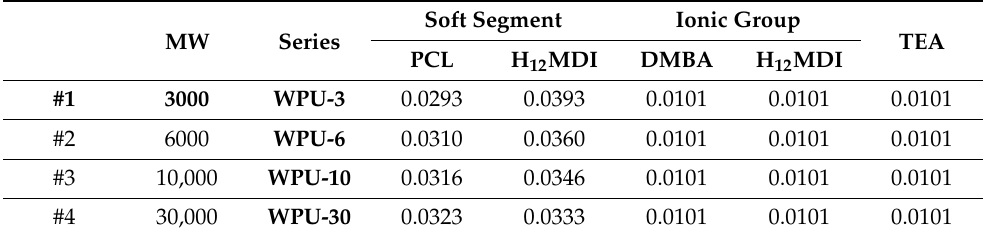
Scheme 1. Schematic diagram of the basic procedure to synthesize the waterborne polyurethanes (WPUs). Table 1. The split composition of the comparative groups (molar ratio). Table 1. The split composition of the comparative groups (molar ratio).